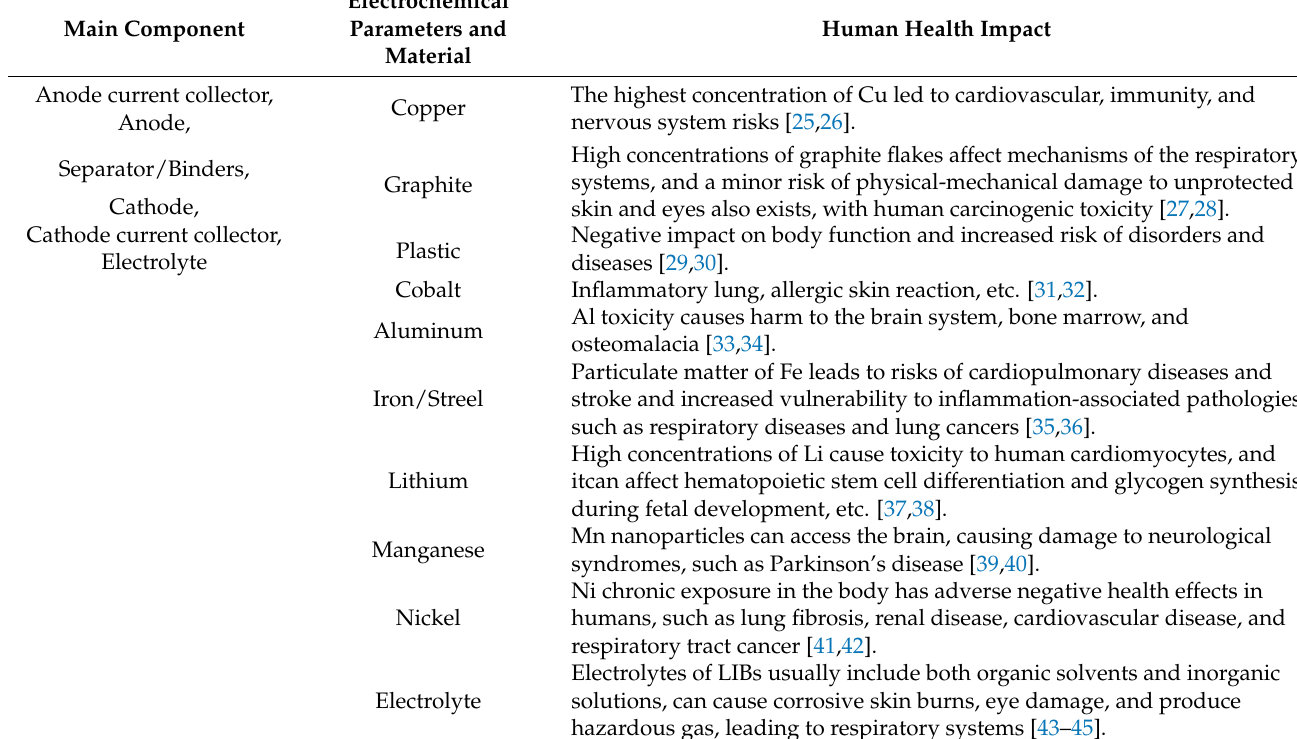
Table 2. Key composition of LCO, NCM, LFP, and LMO batteries and health